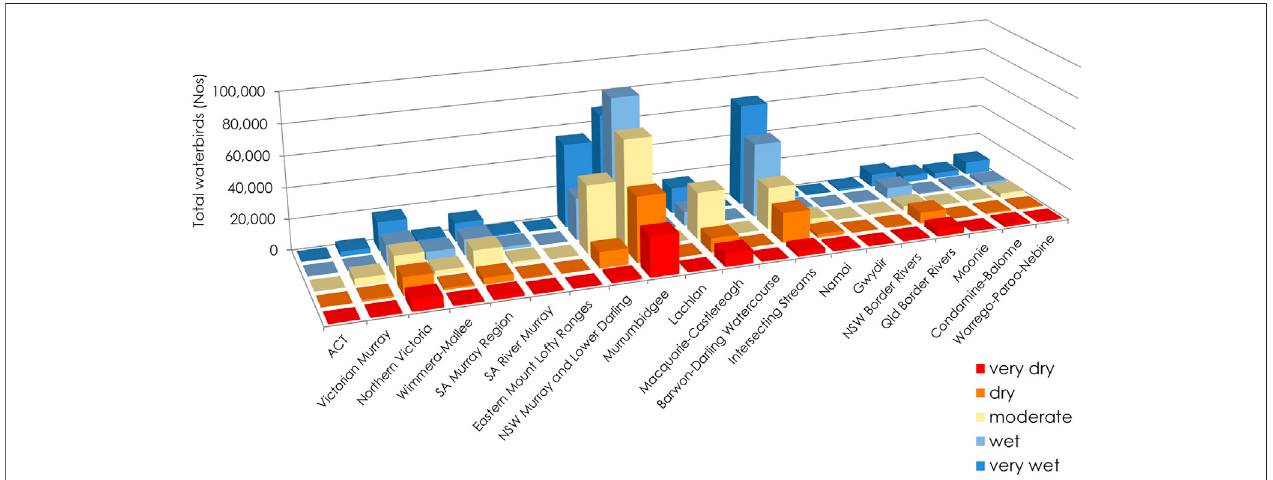
FIGURE 4 | Average annual (1983 – 2020) waterbird abundance from the Eastern Australia Waterbird Survey in each of the Water Resource Planning Area across the Murray-Darling Basin ( Supplementary Appendix S1 for map with labels), strati fi ed by fi ve Surface Water Conditions (SWC).